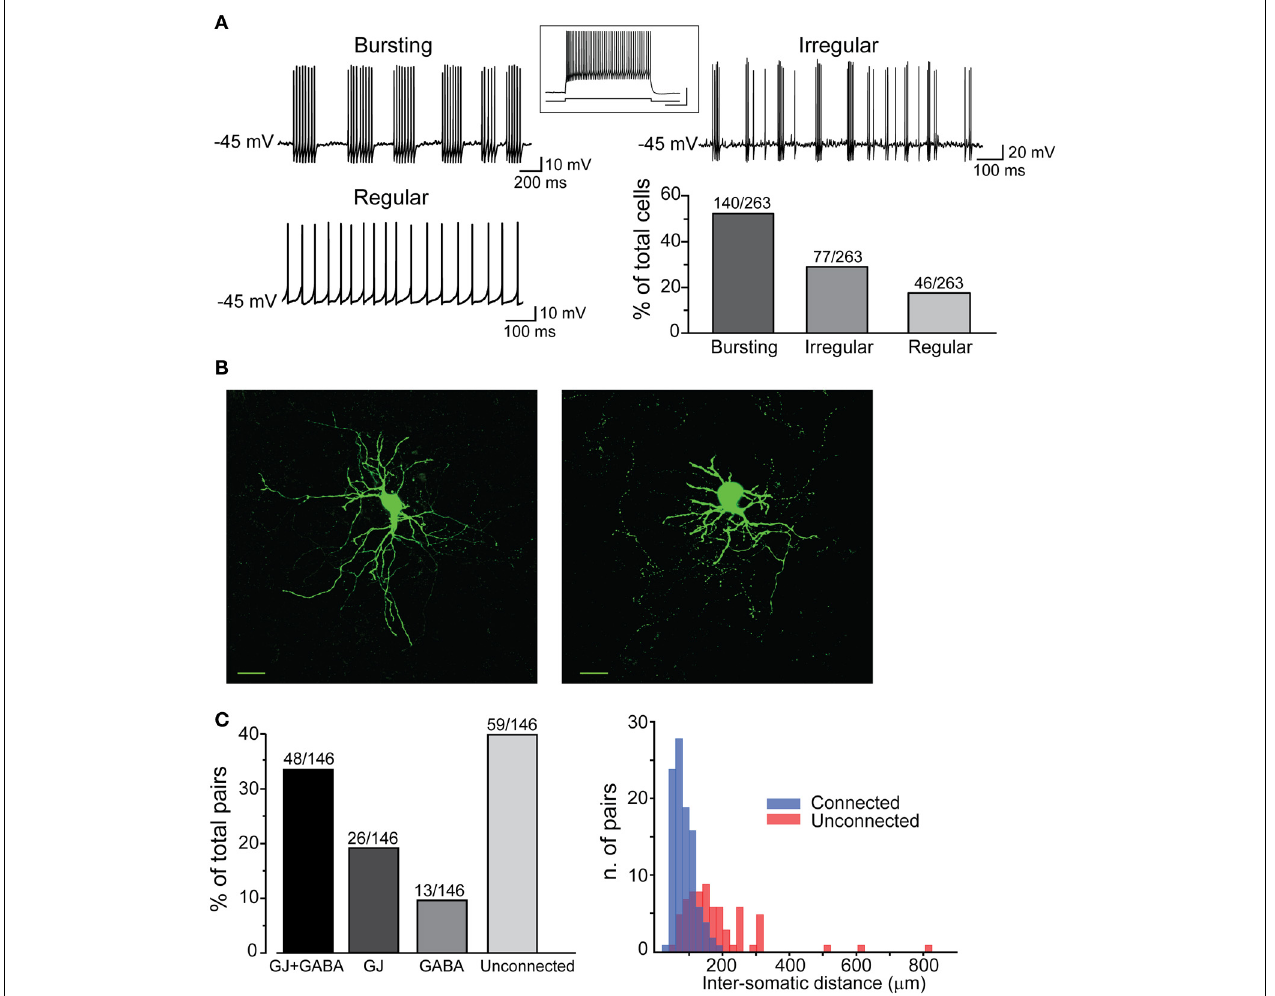
FIGURE 2 | Electrophysiological properties and connectivity patterns of striatal FSIs. (A) Examples of different firing patterns and relative distributions. Traces are excerpts from 20 to 60s lasting recordings in which cells were injected with suprathreshold DC (I inj bursting: 500pA; regular: 400pA; irregular: 500pA). The histogram shows relative distributions of different firing patterns. Inset: high-frequency firing activity